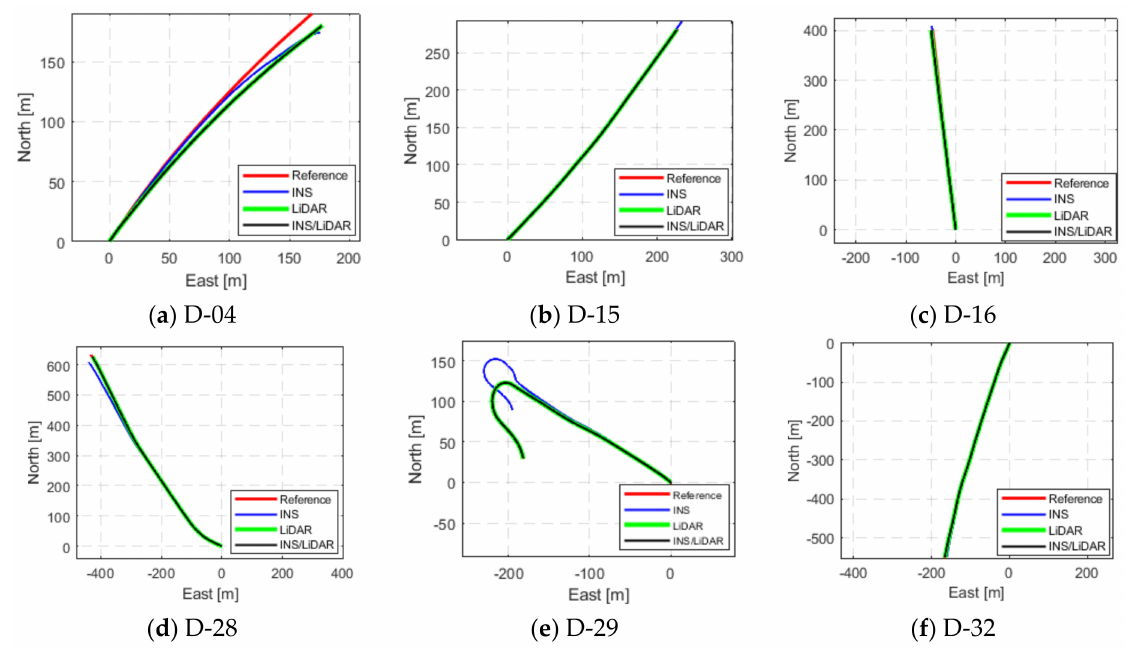
Figure 19. Complete GNNS signal outage: comparison of trajectories.